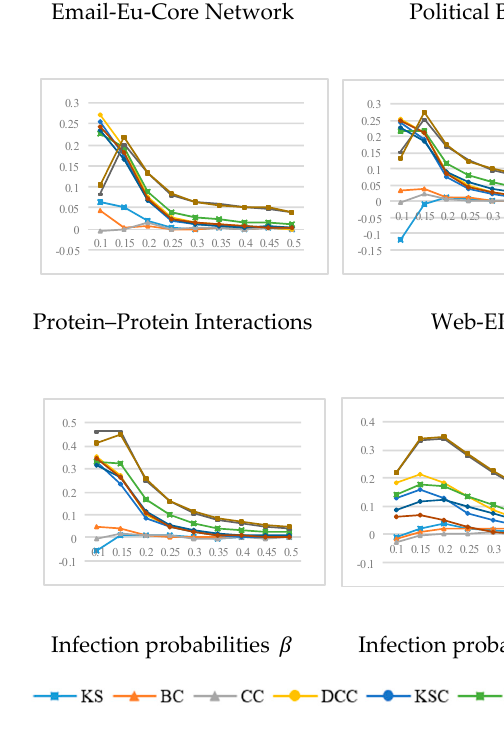
Figure 3. In the single-point contact SIR model, the relationship between Δ and 𝛽 with 3% nodes in the key node set.